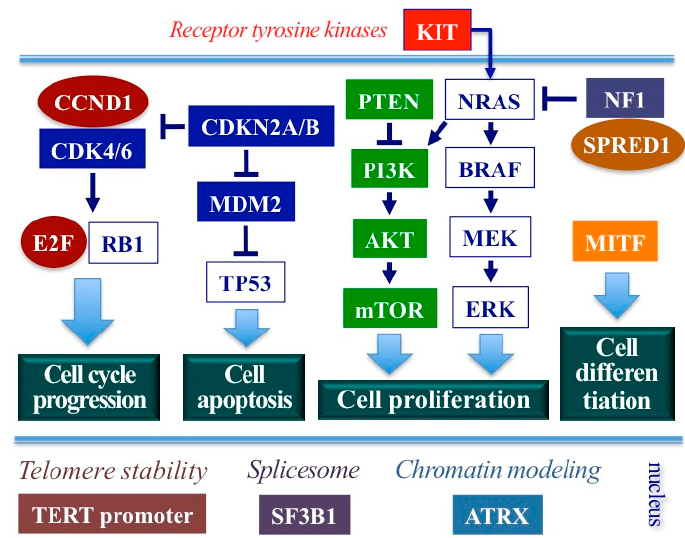
Figure 1. Main genes and their functional role in MM. ATRX, ATP-dependent helicase; BRAF, B-Raf proto-oncogene; CDK4/6, Cyclin-dependent kinase 4/6; CCND1, Cyclin D1; CDKN2A/B, Cyclin-dependent kinase inhibitor of kinase 2A/B; E2F, E2F transcription factor 2; ERK, Extracellular-related kinase; KIT, receptor tyrosine kinase; MDM2, mouse double minute 2 p53 binding protein homolog; MITF, Microphthalmia-associated transcription factor; MEK, Mitogen-activated protein kinase-extracellular related kinase; mTOR, mammalian target of rapamycin; NF1, neurofibromin 1; NRAS, neuroblastoma RAS viral oncogene homolog; PI3K, Phosphatidylinositol 3 kinase; PTEN, Phosphatase and tensin homologue; RB1, retinoblastoma 1; SF3B1, splicing factor 3b subunit 1; SPRED1, sprout-related EVH1 domain containing protein 1; TERT, telomerase reverse transcriptase; TP53, tumor protein p53.